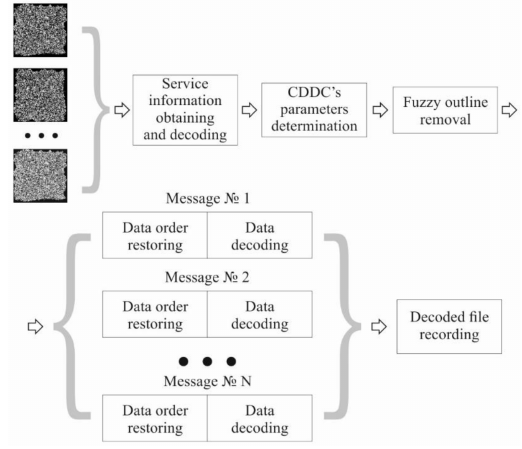
Figure 4. The algorithm of MCDDC data